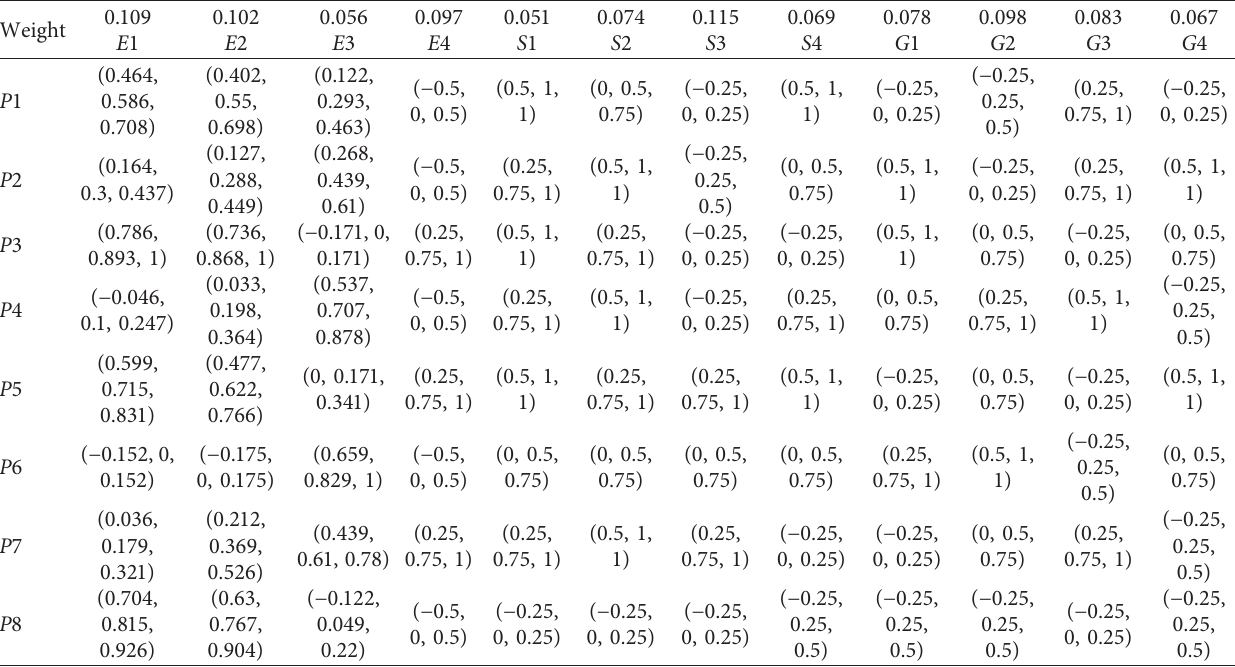
Table 43: Normalized decision matrix in fuzzy condition.